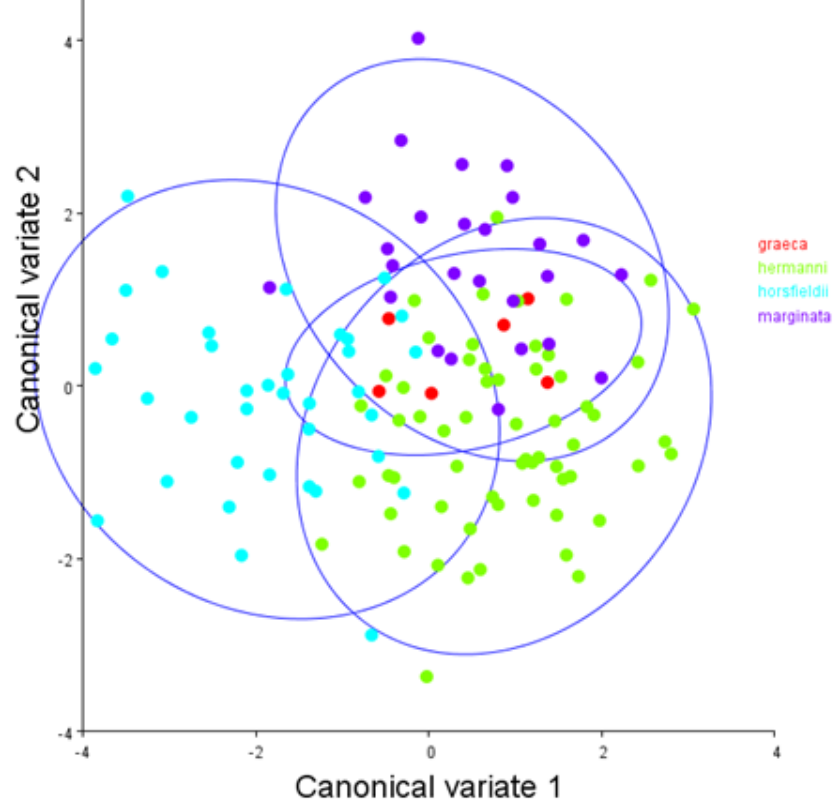
Figure 2. Canonical Variate Analysis for 4 Testudo species ( T. hermanni n = 30, T. graeca n = 3, T. marginata n = 13 and T. horsfieldii n = 18) along the first two Canonical variate axes with 90% confidence ellipses for each species. This scatterplot shows an overlap among species.